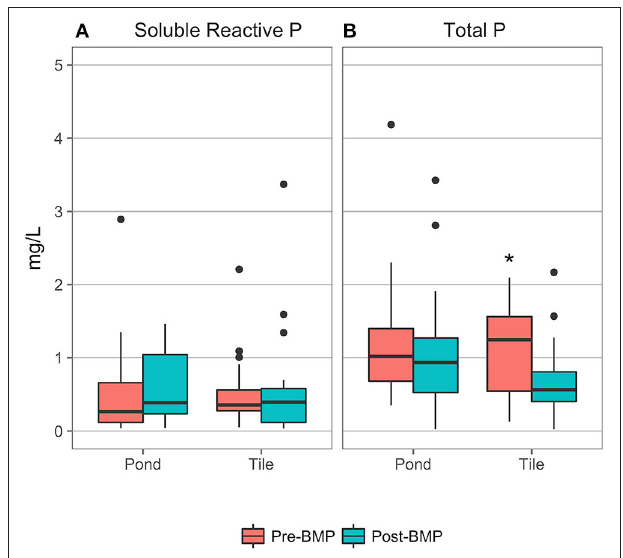
FIGURE 7 | Point source SRP (A) and TP (B) concentrations pre- and post-BMP installation. Pond and Tile correspond with Pond and Tile sources from Figure 6 . Statistical differences are noted by an asterisk (*). N = 24, 28 for pre- and post-BMP samples at source 1. N = 24, 28 for pre- and post-BMP samples taken from Source 2,